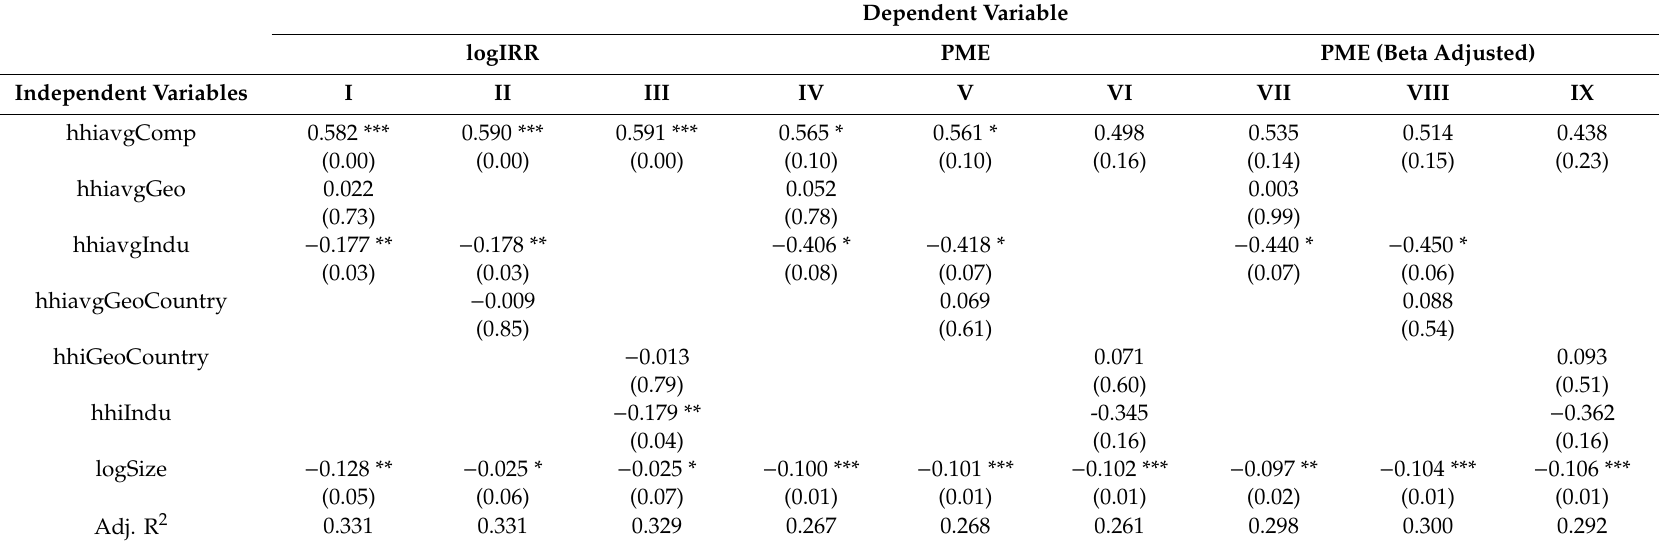
Table A4. Robustness tests (diversification